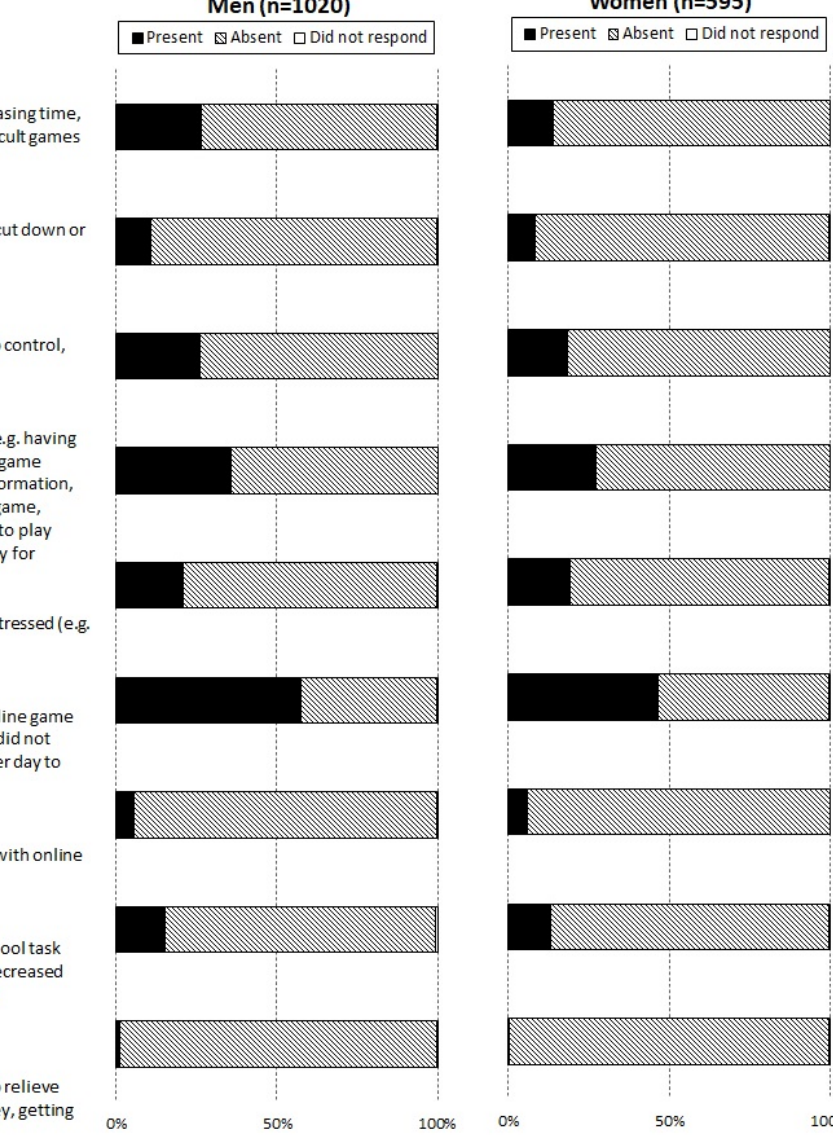
Figure 1. Presence of problem gambling behaviors among adolescent